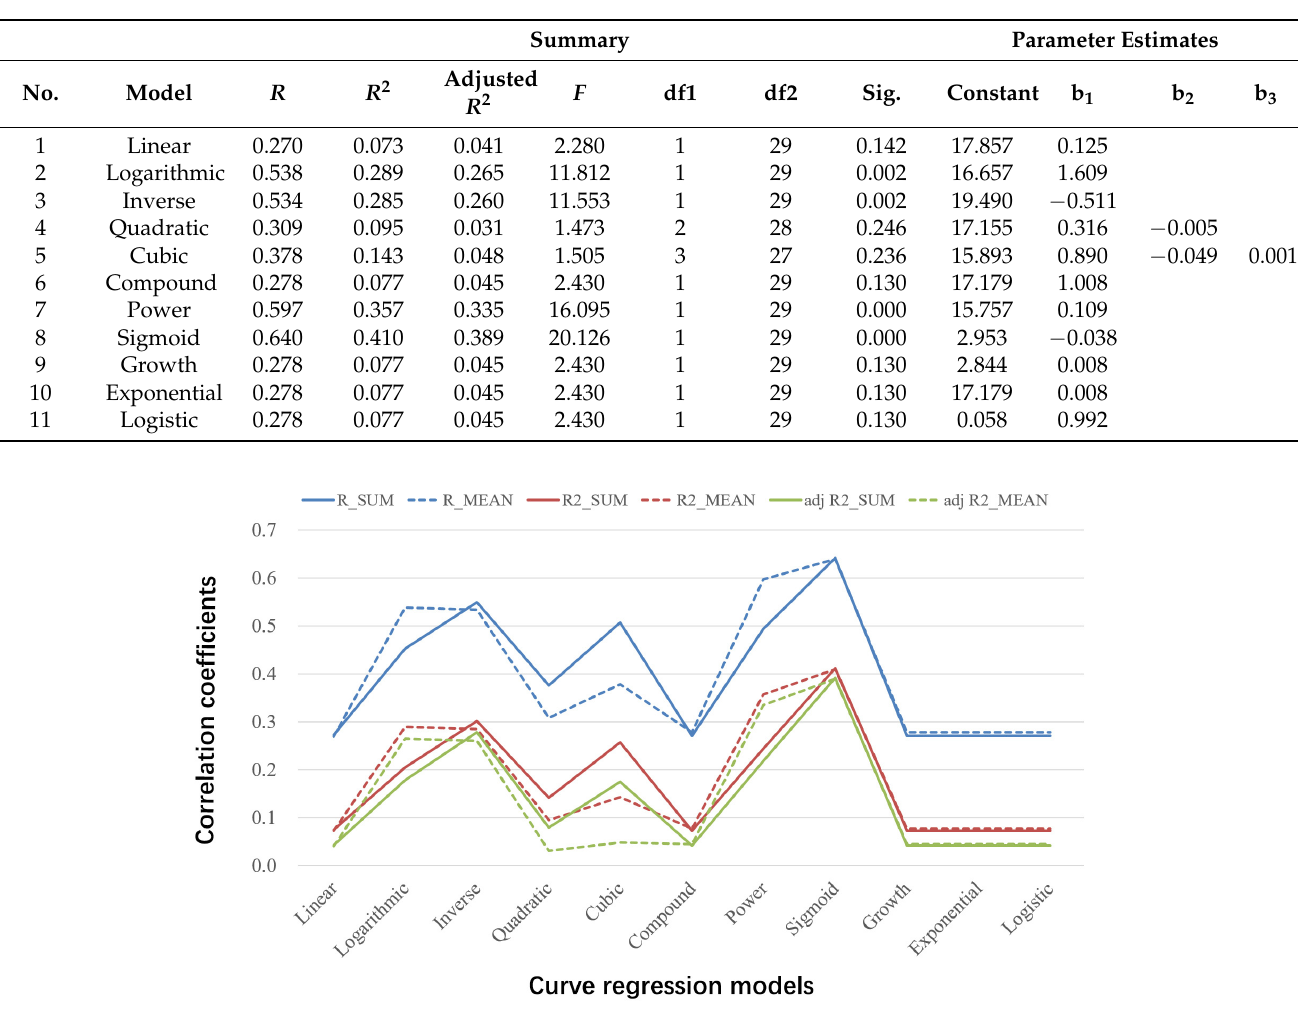
Table A3. Summary and parameter estimates for all models (the provincial MEAN of DN as an argument).